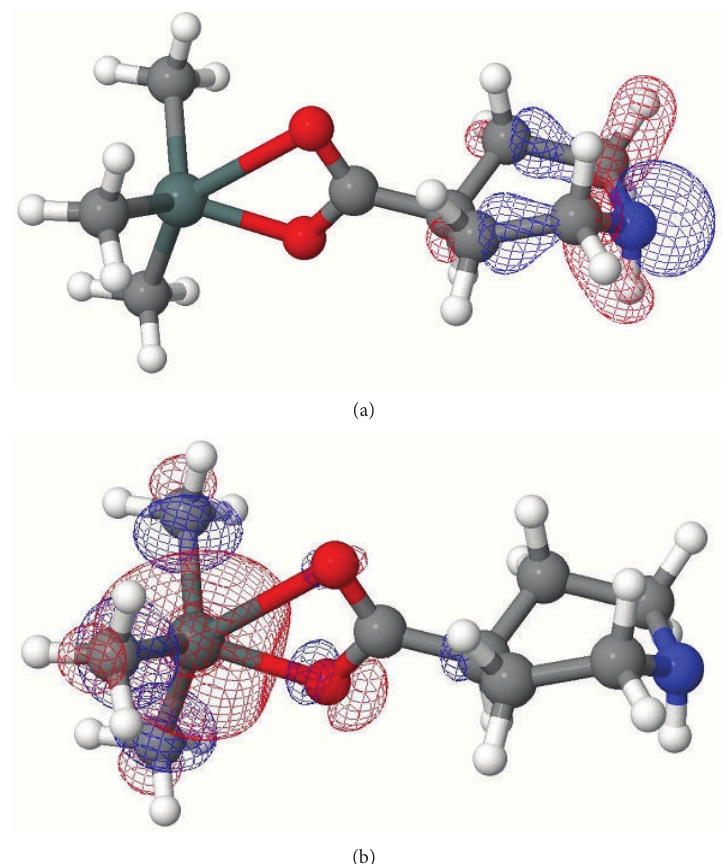
Figure 4: (a) HOMO of complex 4 ; (b) LUMO of complex 4